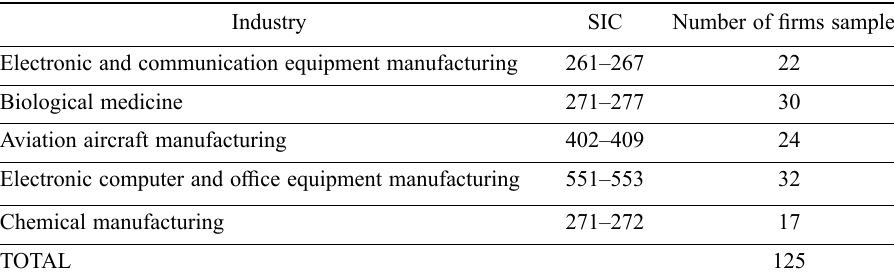
Table 1. Sample industry